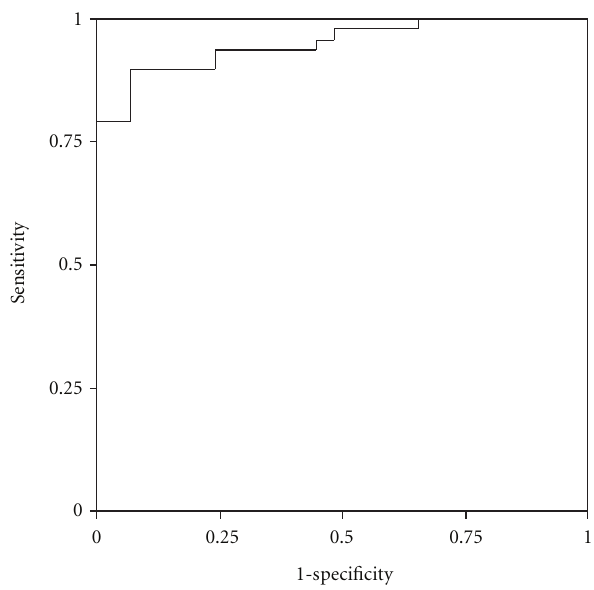
Figure 1: Receiver operating characteristic curve analysis of cumu- lative percent oxidation of methacetin at 40 minutes in patients with and without cirrhosis.